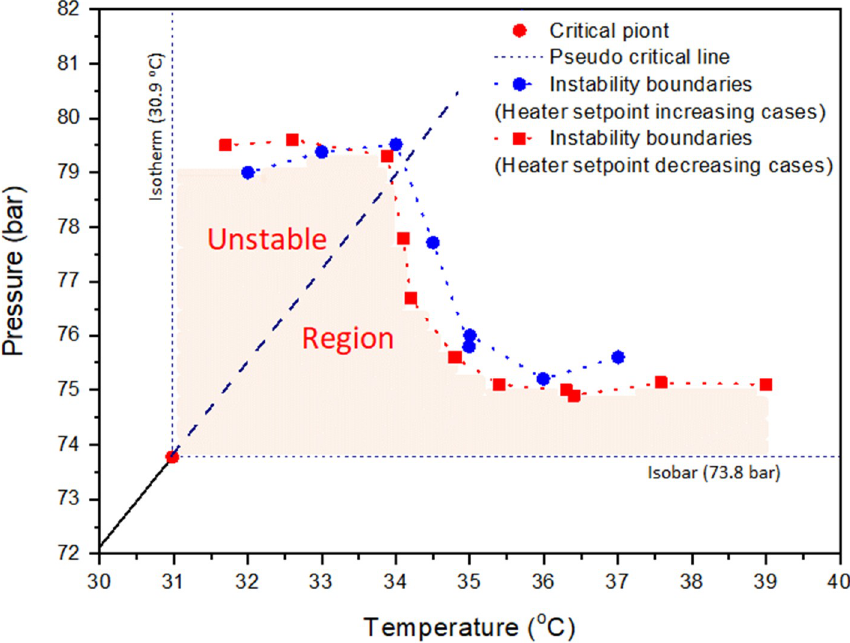
Figure 7. Unstable region of supercritical CO 2 .